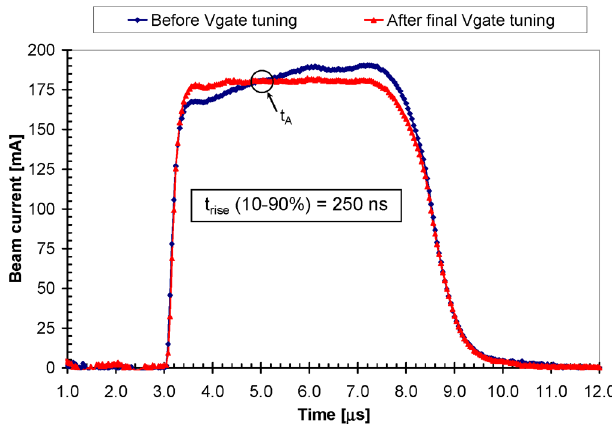
FIG. 15. (Color) Beam current comparison [before (blue) and after (red) extraction voltage adjustments] measured at the exit of the injector with a current transformer.